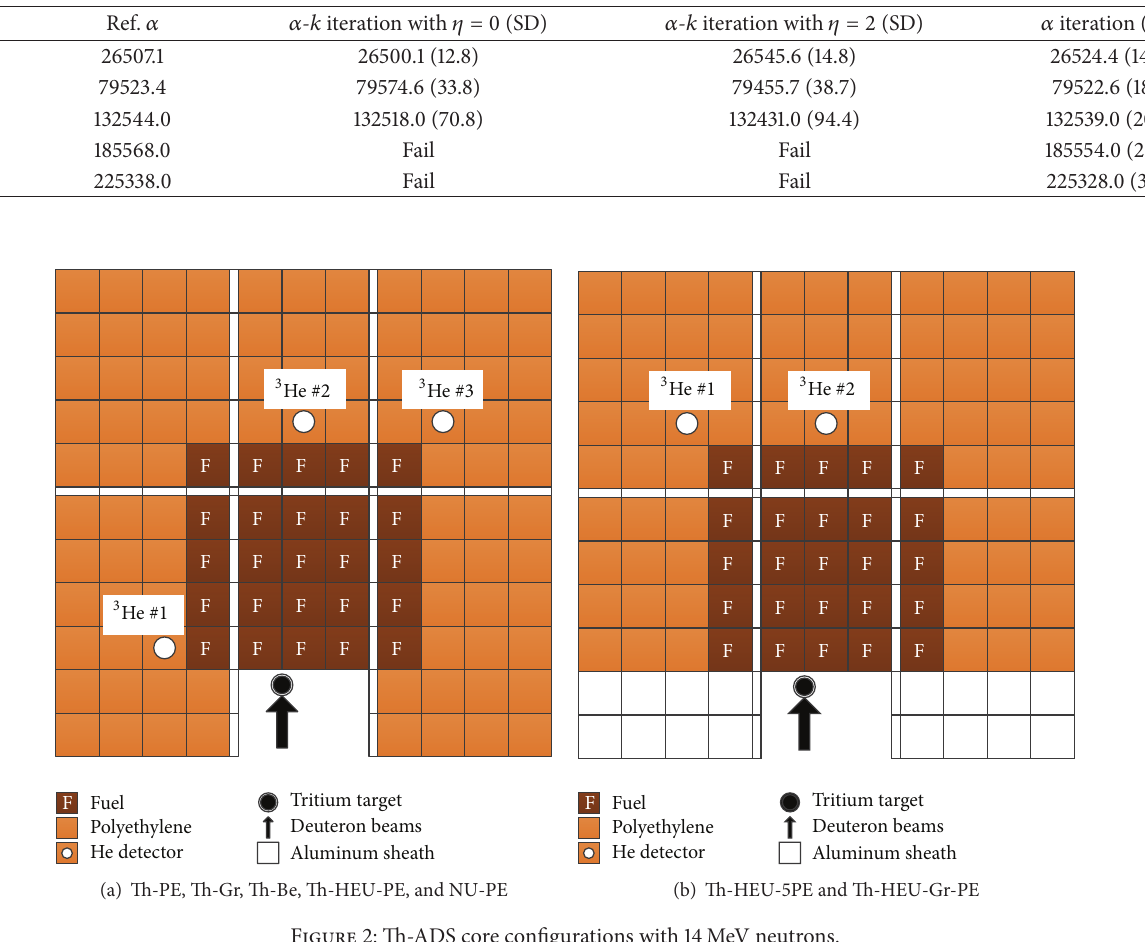
Figure 2: Th-ADS core configurations with 14MeV